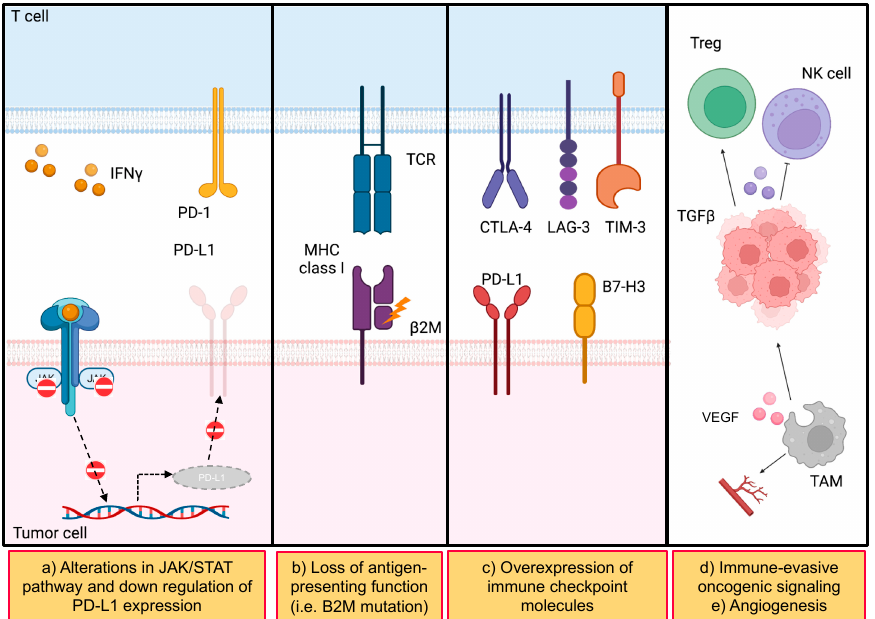
Figure 3. Mechanisms of resistance for immunotherapy in MSI-H/dMMR cancers. Adapted from “Drug Targeting in Cytokine Receptor Pathways,” by BioRender.com (2022). Retrieved from https:// app.biorender.com/biorender-templates (accessed on 28 October 2022). Created with